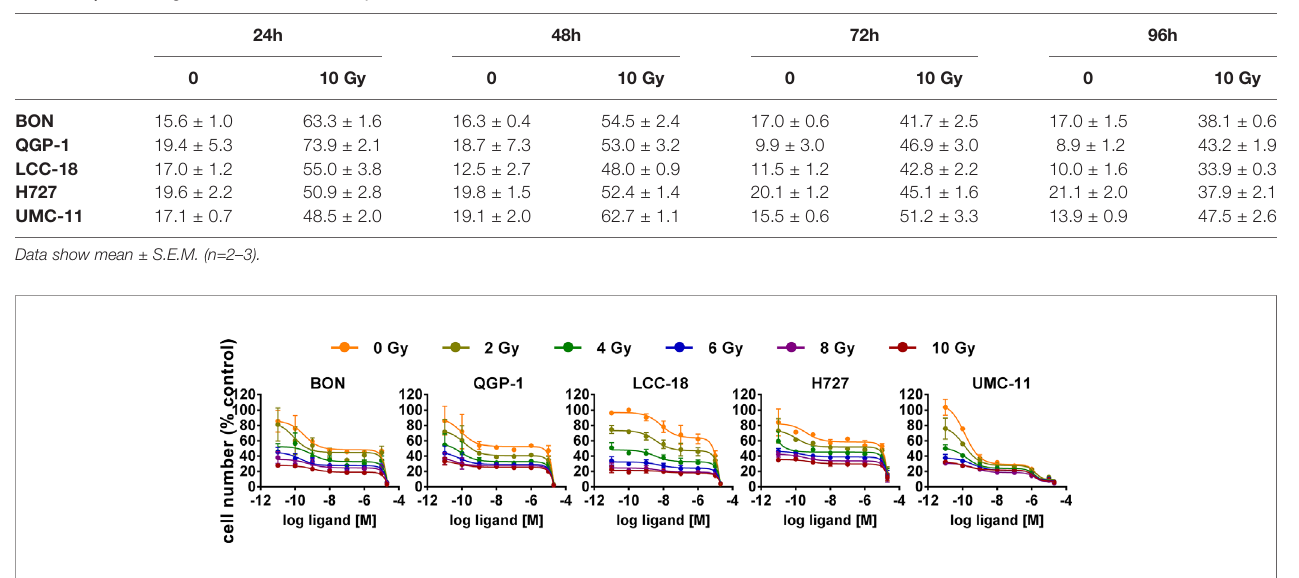
FIGURE 6 | Additive effect of temsirolimus and irradiation on NEN cell numbers. NEN cell lines were pretreated with increasing concentrations of temsirolimus (0.01 nM to 20 µM) for 24 h before irradiation. Cell number was determined 96 h after irradiation with different doses of 0 – 10 Gy. Graphs show mean ± S.E.M. (n=2 –